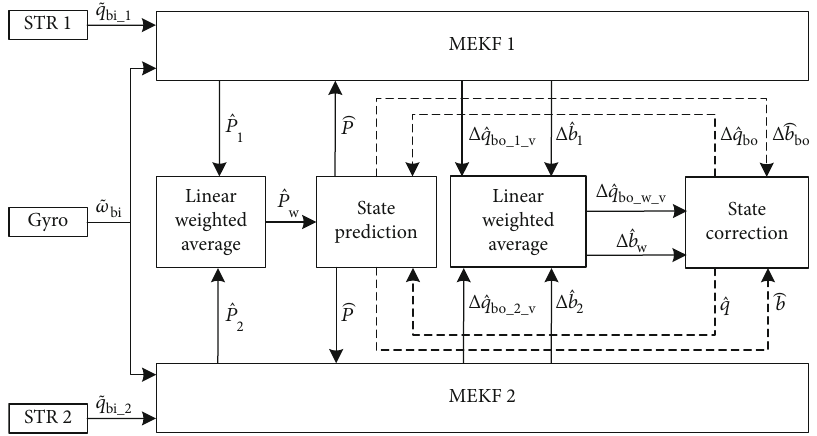
Figure 8: The decentralized